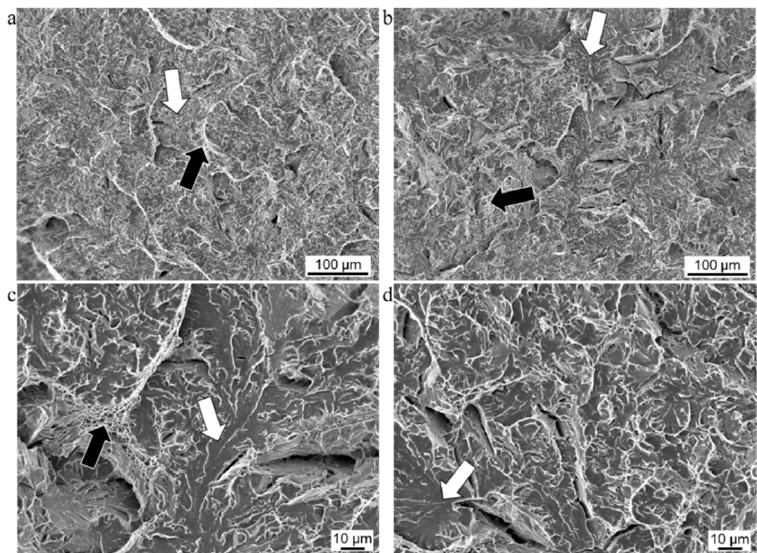
Figure 7. Fractography of samples fractured at − 20 °C from the top of the build ( a ) and the bottom of the build ( b ). High magnification images ( c ) and ( d ) from the top and bottom of the build respectively. White arrows indicate regions of cleavage, and the black arrows indicate regions of ductile failure.